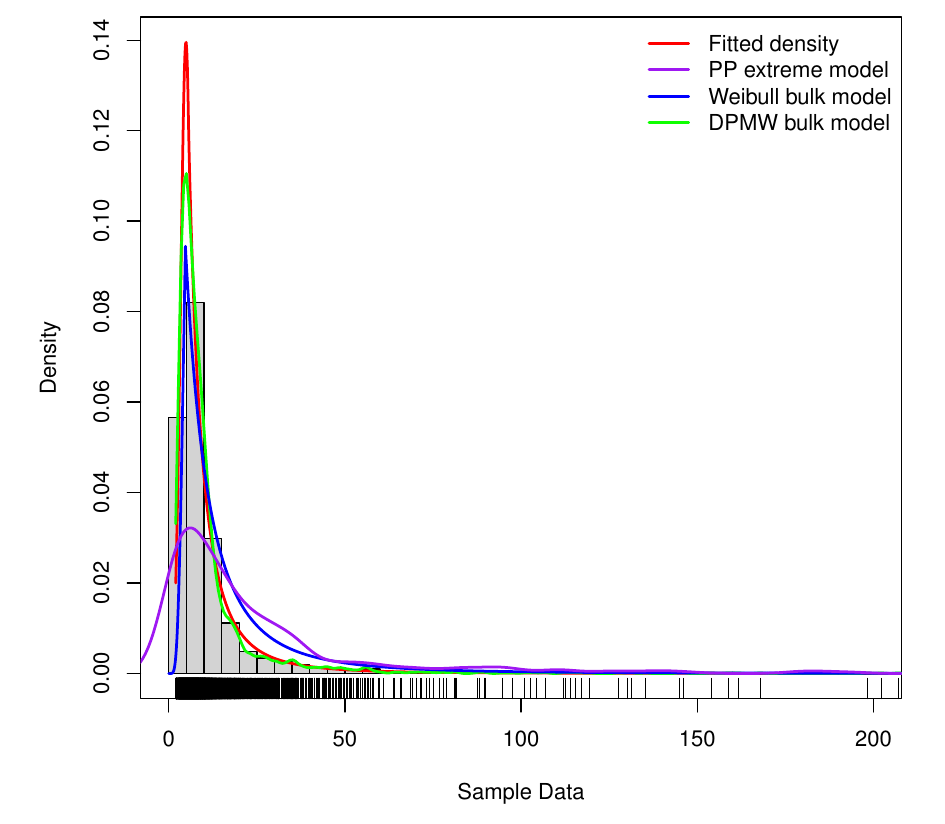
Figure 21. The posterior density plot for three models (the DPMW-PPR model, the PP extreme value model and the WMPP extreme model) fitted to the Patuxent river daily flow. The red line shows the true density function, the green line, the blue line and the purple line are the posterior density function of the DPMW-PPR model, the WMPP extreme model and the PP extreme value model,